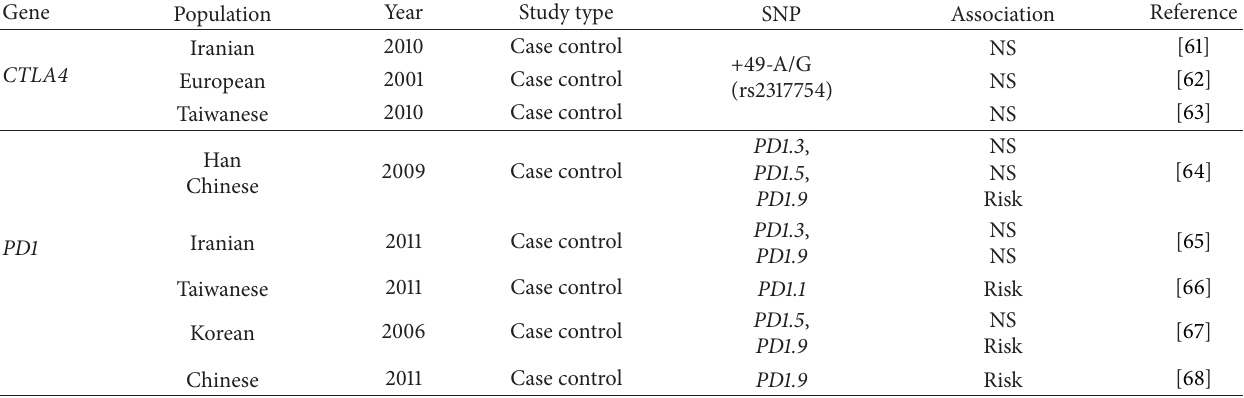
Table 2: Association studies between CTLA4 +49-A/G and PD1 polymorphisms with ankylosing spondylitis.